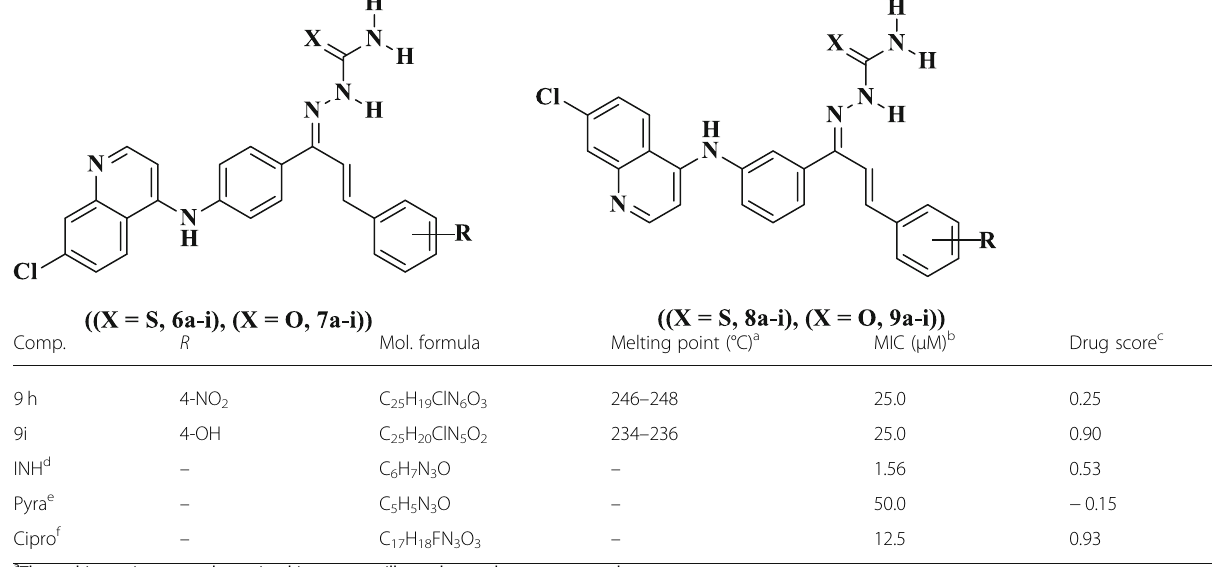
Table 1 Physical data and antimycobacterial activities of compound ( 6a-i ), ( 7a-i ), ( 8a-i ), and ( 9a-i ) against MTB H 37 Rv (Continued)